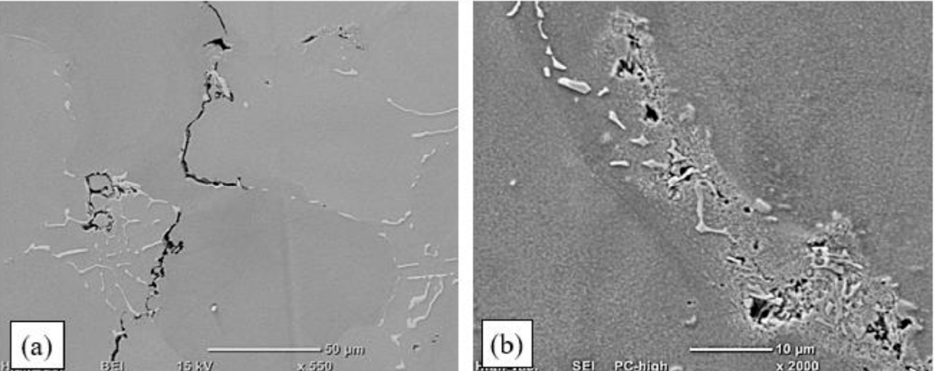
Figure 11. Structure of an Inconel 713C padding weld obtained by TIG welding with Inconel 625 as the filler material (E l = 0.35 kJ/mm): ( a ) crack in the area of Chinese script carbide precipitates, SEM; ( b ) material discontinuities in the HAZ, in the area of the γ - γ (cid:48) eutectic mixture and